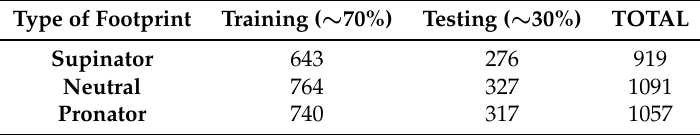
Table 1. Number of dataset steps used for training and testing.